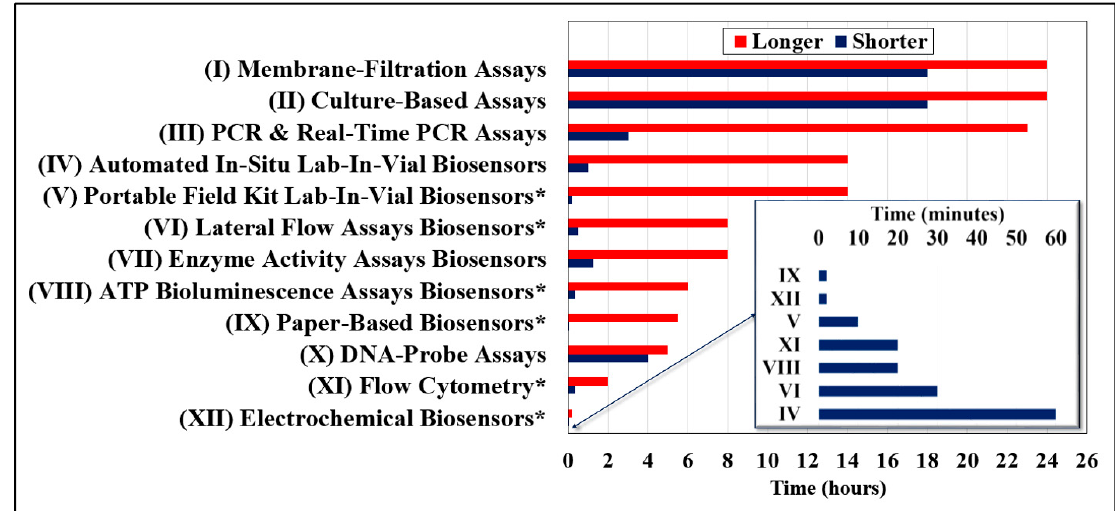
Figure 2. Histogram of times to result of review-identified monitoring tools. Includes an additional plot (lower right) of the fastest times in minutes; these times (*) potentially exclude preprocessing.